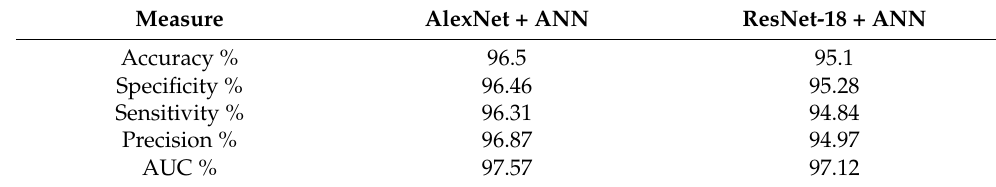
Table 5. Evaluative performance of the ANN based on deep features for early diagnosis of OSCC.